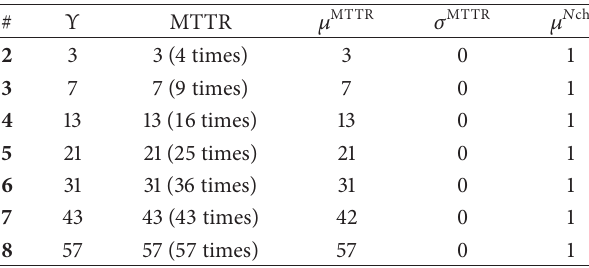
Table 5: A-MOCH [30] in SCHv ( 𝑟, 𝑛) = {(2,4) , (3,9) , (4, 16) , (5,25) , (6,36) , (7,49) , (8,64)}